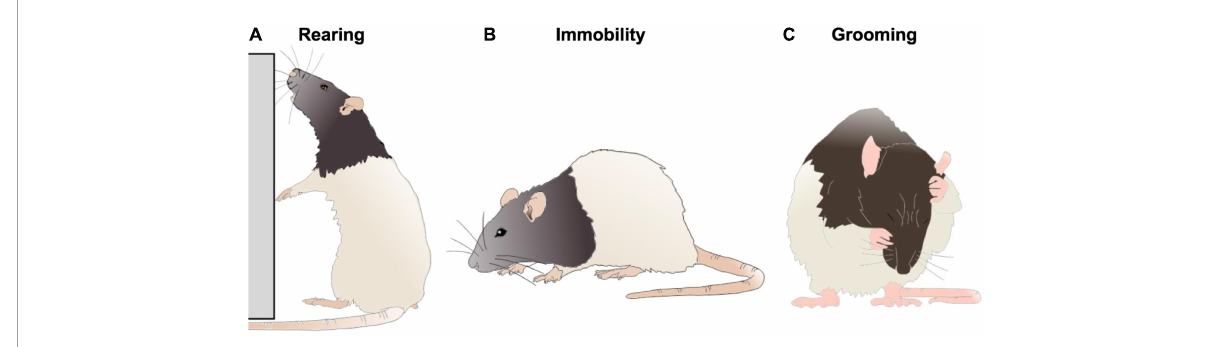
FIGURE3 A depiction of a rat engaging in rearing (A) , immobility (B), and grooming (C) behaviors. Figure adapted from scidraw.io under Creative Commons 4.0 license.